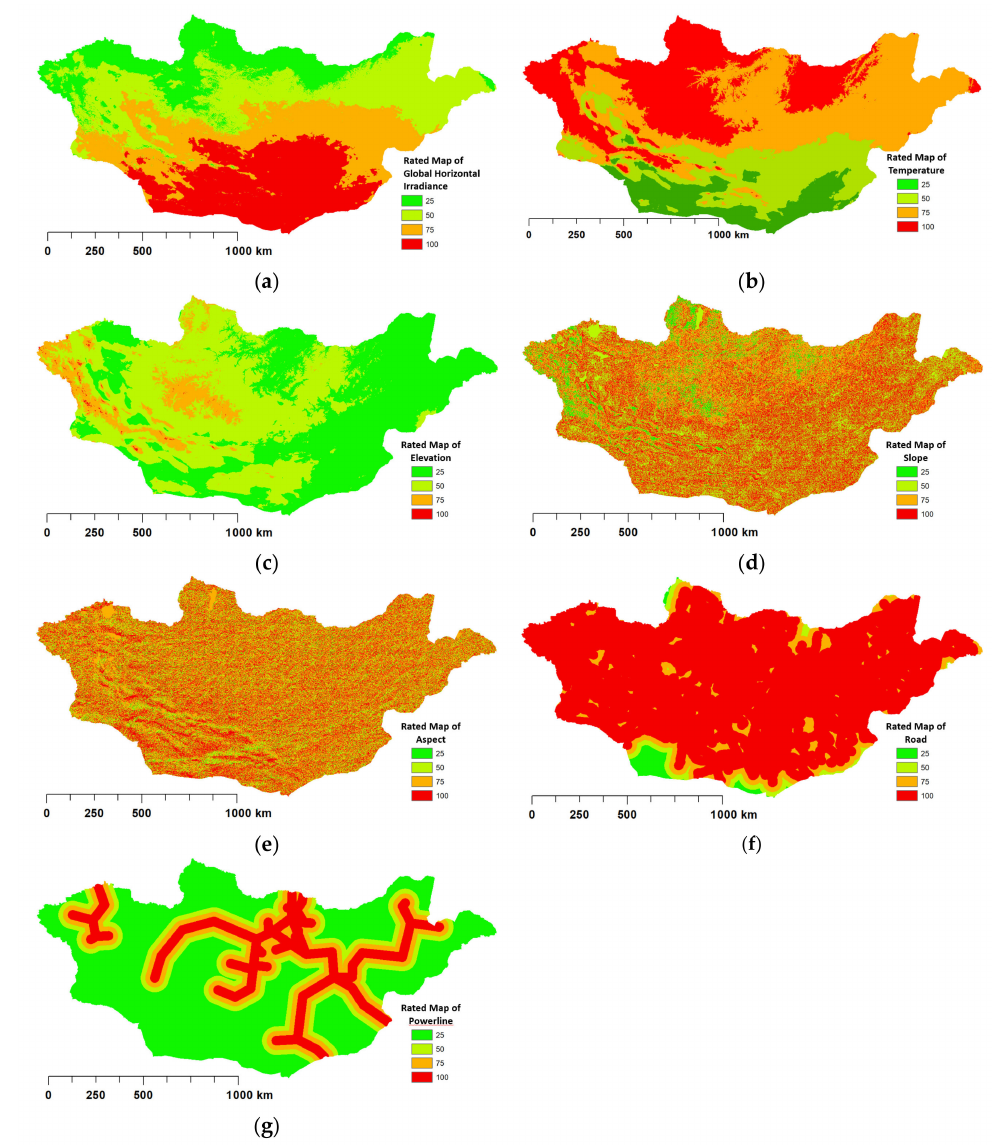
Figure 10. Criteria rating maps used in this study for Mongolian PV site suitability analysis: ( a ) global horizontal irradiation; ( b ) temperature; ( c ) elevation; ( d ) slope; ( e ) aspect; ( f ) distance from a main road; and ( g ) distance from a major